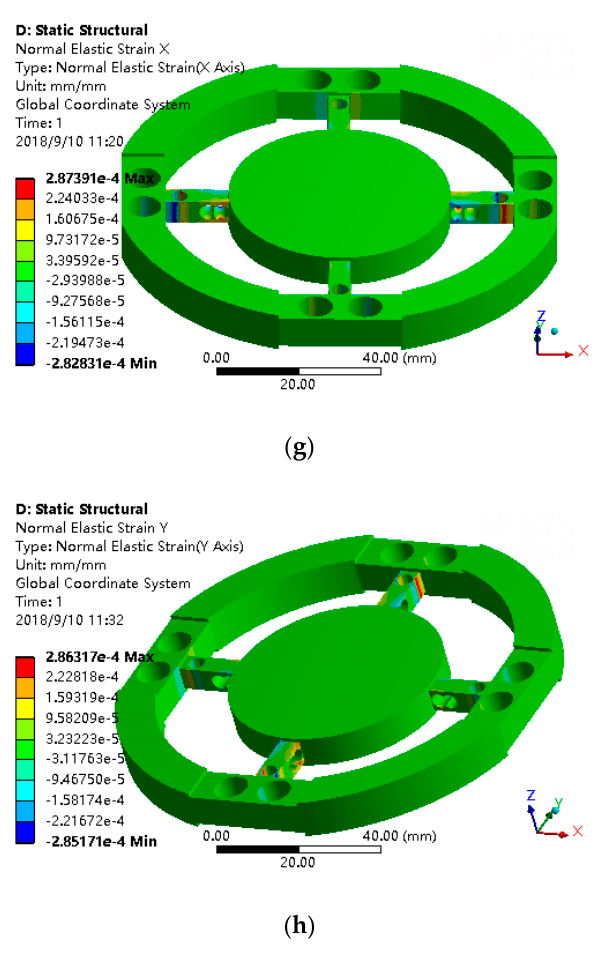
Figure 12. ( a ) The X direction strain under F x = 50 N. ( b ) The Y direction strain under F x = 50 N. ( c ) The X direction strain under F z = 50 N. ( d ) The Y direction strain under F z = 50 N. ( e ) The X direction strain under M x = 2.5 N · m. ( f ) The Y direction strain under M x = 2.5 N · m. ( g ) The X direction strain under M z = 2.5 N · m. ( h ) The Y direction strain under M z = 2.5 N · m.